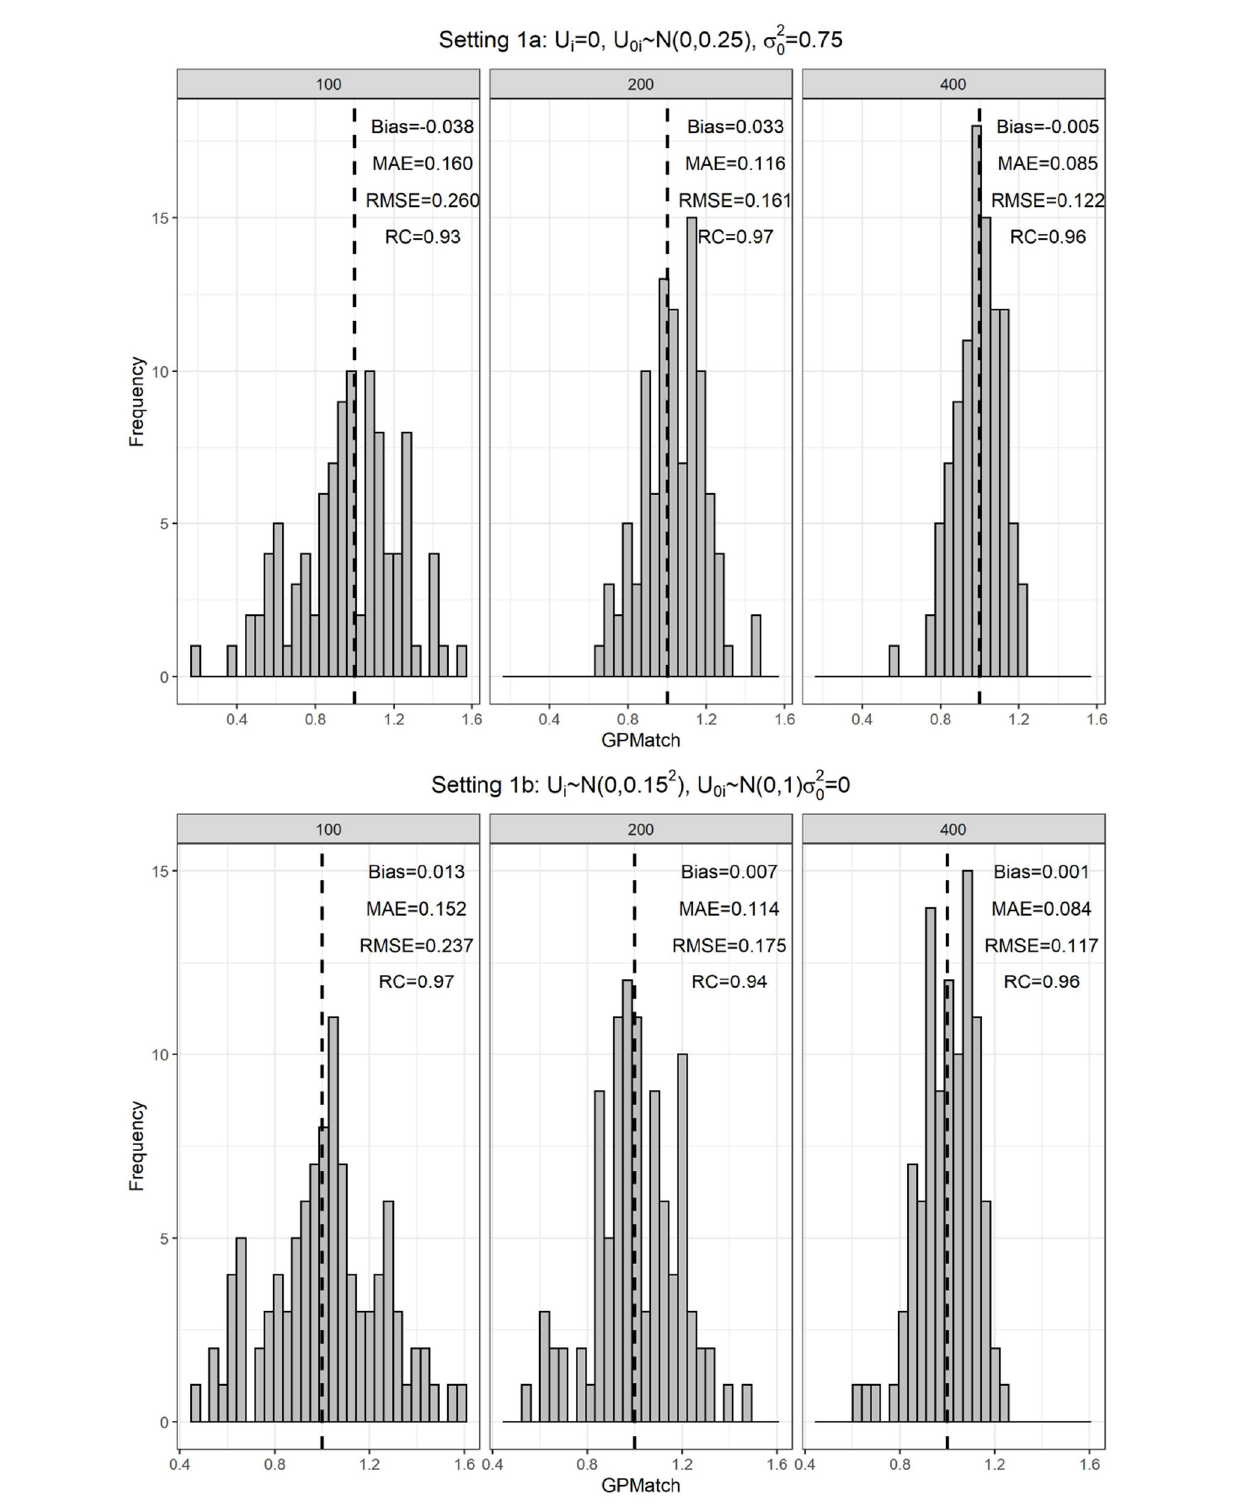
FIGURE1 Distribution of the GPMatch estimate of ATE, by different sample sizes under the single covariate simulation study